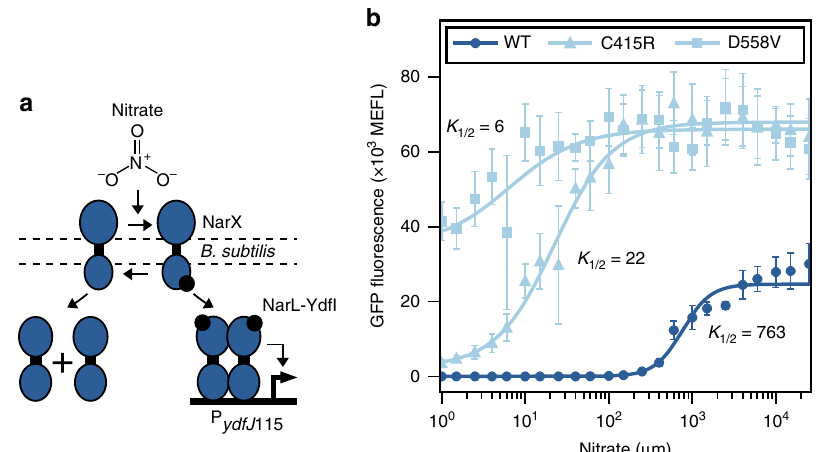
Fig. 2 Phosphatase-reducing mutations decrease detection threshold in a B. subtilis nitrate sensor. a An engineered B. subtilis nitrate-sensing TCS. The E. coli SK NarX signals to a chimeric RR composed of the N-terminal Receiver (REC) domain of E. coli NarL fused to the C-terminal DNA binding domain (DBD) of B. subtilis YdfI (Supplementary Fig. 2). Phosphorylated NarL-YdfI activates transcription from the B. subtilis P ydfJ variants from ( a ) containing wild-type NarX, NarX(C415R), and NarX(D558V). Points represent the mean and error bars the standard error of the mean (SEM) of experiments on three separate